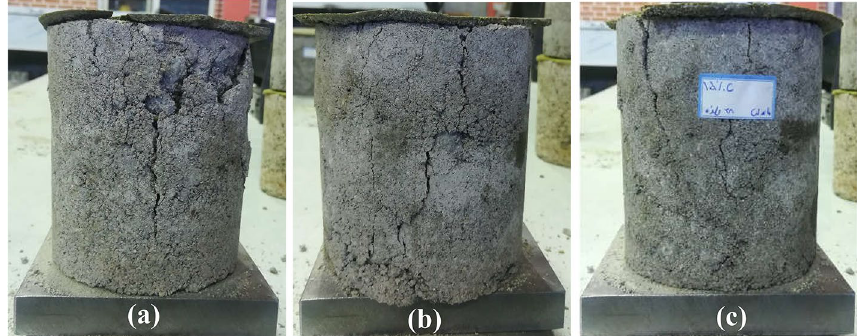
Fig. 9 The failure mode of CSG mixture samples (without fine grained additive) at the curing age of 28 days: a S-C5 sample, b S-C10 sample, c S-C15